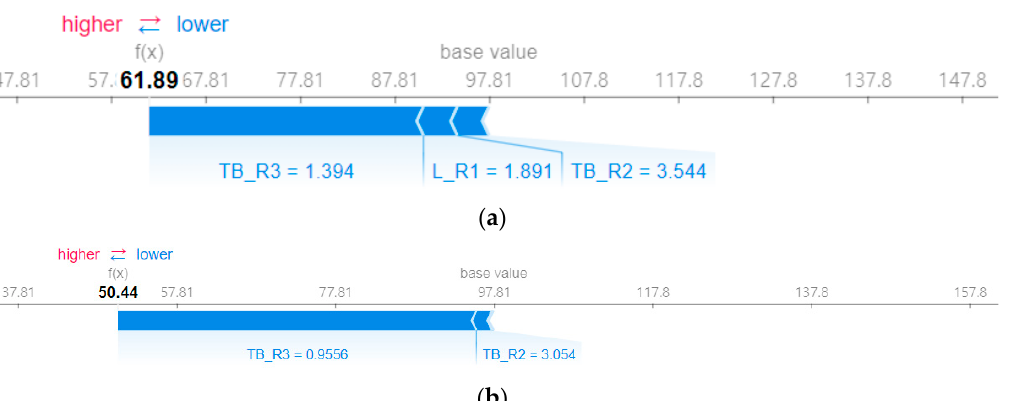
Figure 7. SHAP summary plot.